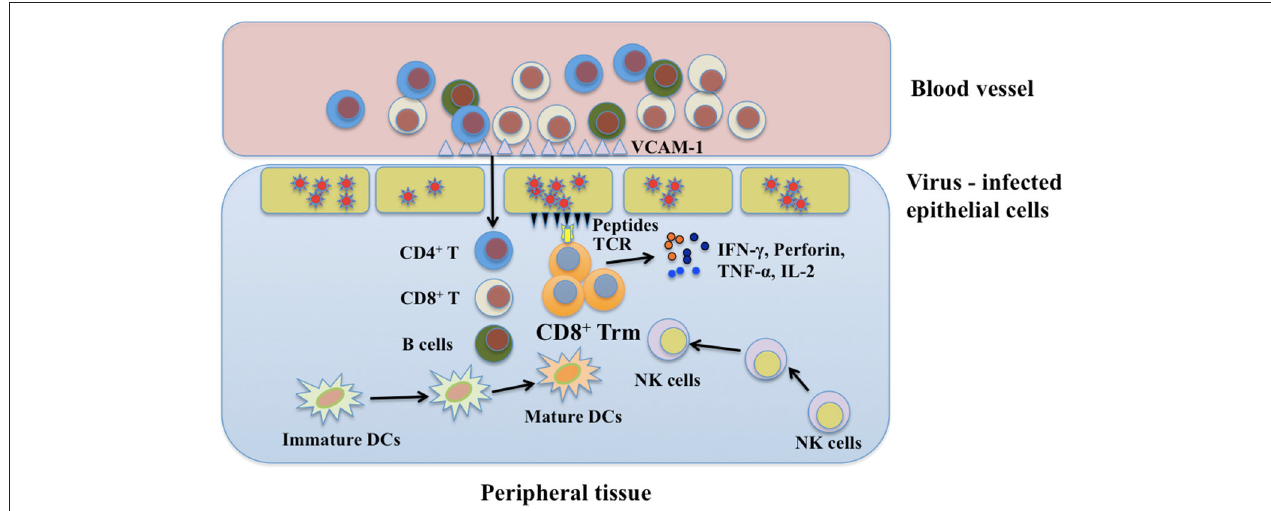
FIGURE 3 | The protective function of CD8 + Trm cells in viral infection. Upon encountering the same pathogen, CD8 + Trm cells can be reactivated immediately and secrete cytokines in which IFN- γ may help recruit immune cells from blood stream via enhancing expression of endothelial vessel addressin. These immune cells include CD4 + T cells, CD8 + T cells, and B cells. Besides, NK cells and immature DCs in local tissue can also be recruited to the place where CD8 + Trm cells are reactivated. CD8 + Trm cells cooperate with these immune cells to synergistically combat with viruses by secreting perforin, IFN- γ , and TNF- α . Trm, resident memory T cells; DCs, dendritic cells; NK, natural killer; IFN- γ , interferon- γ ; TNF- α , tumor necrosis factor- α ; IL-2, interleukin-2; VCAM-1, vascular cell adhesion